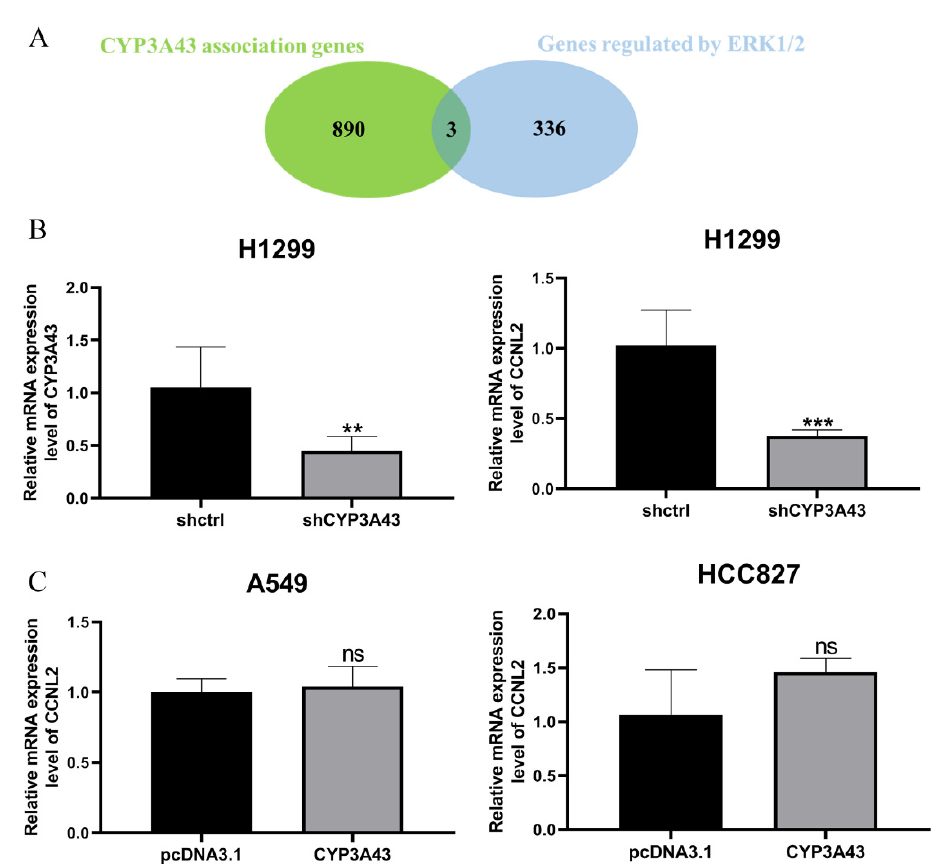
Figure 8. CCNL2 expression was decreased in the stable CYP3A43-knockdown H1299 cells. ( A ) A Venn diagram showing the number of overlapping genes between the two gene sets (CYP3A43 co-expressed genes and genes that may be regulated by the ERK1/2 downstream transcription factors). ( B ) Decreased CCNL2 mRNA levels were detected in the H1299 cells with stable knockdown of CYP3A43 expression. ( C ) CYP3A43 overexpression in the A549 and HCC827 cells had no effect on CCNL2 mRNA expression. **, p < 0.01; ***, p < 0.001; ns, p > 0.05.